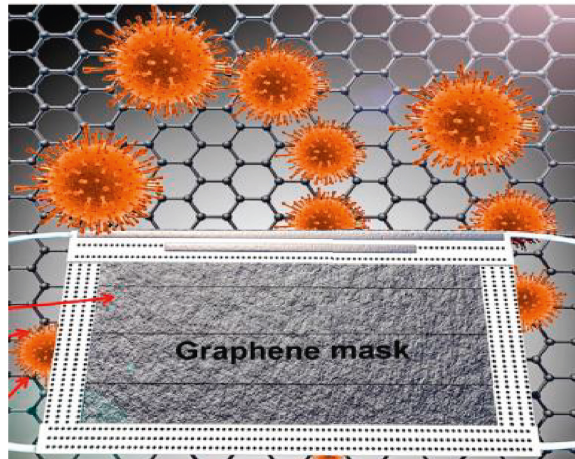
Figure 3: Schematic diagram of laser-induced graphene (adapted with permission from ref.